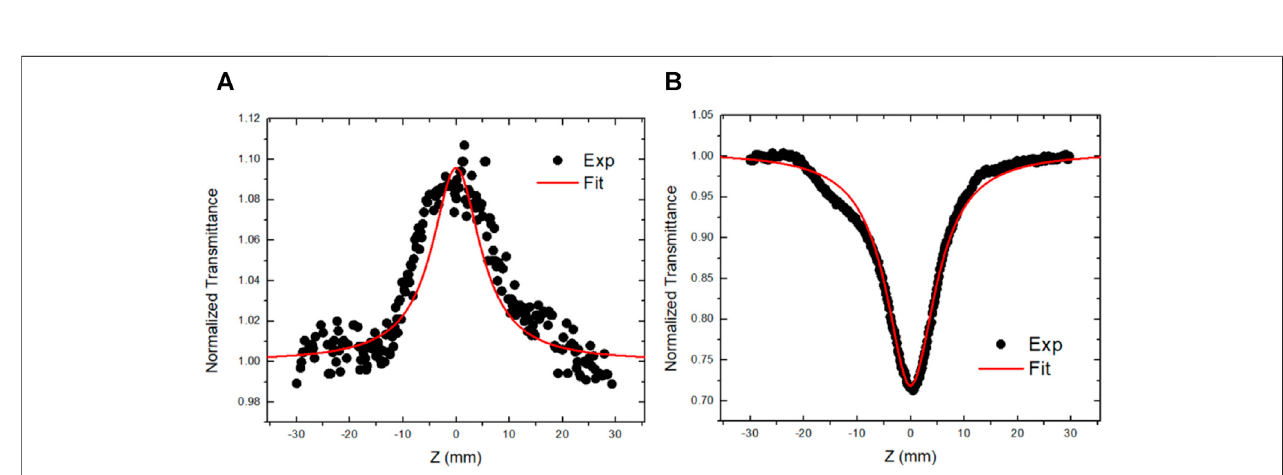
FIGURE 2| Femtosecond open aperture Z-scan curvesof the multilayer β -GaS thin fi lms under (A) 532 nm and (B) 650 nm excitations, respectively. The dots are the experimental data and the solid lines are the theoretical fi tting.